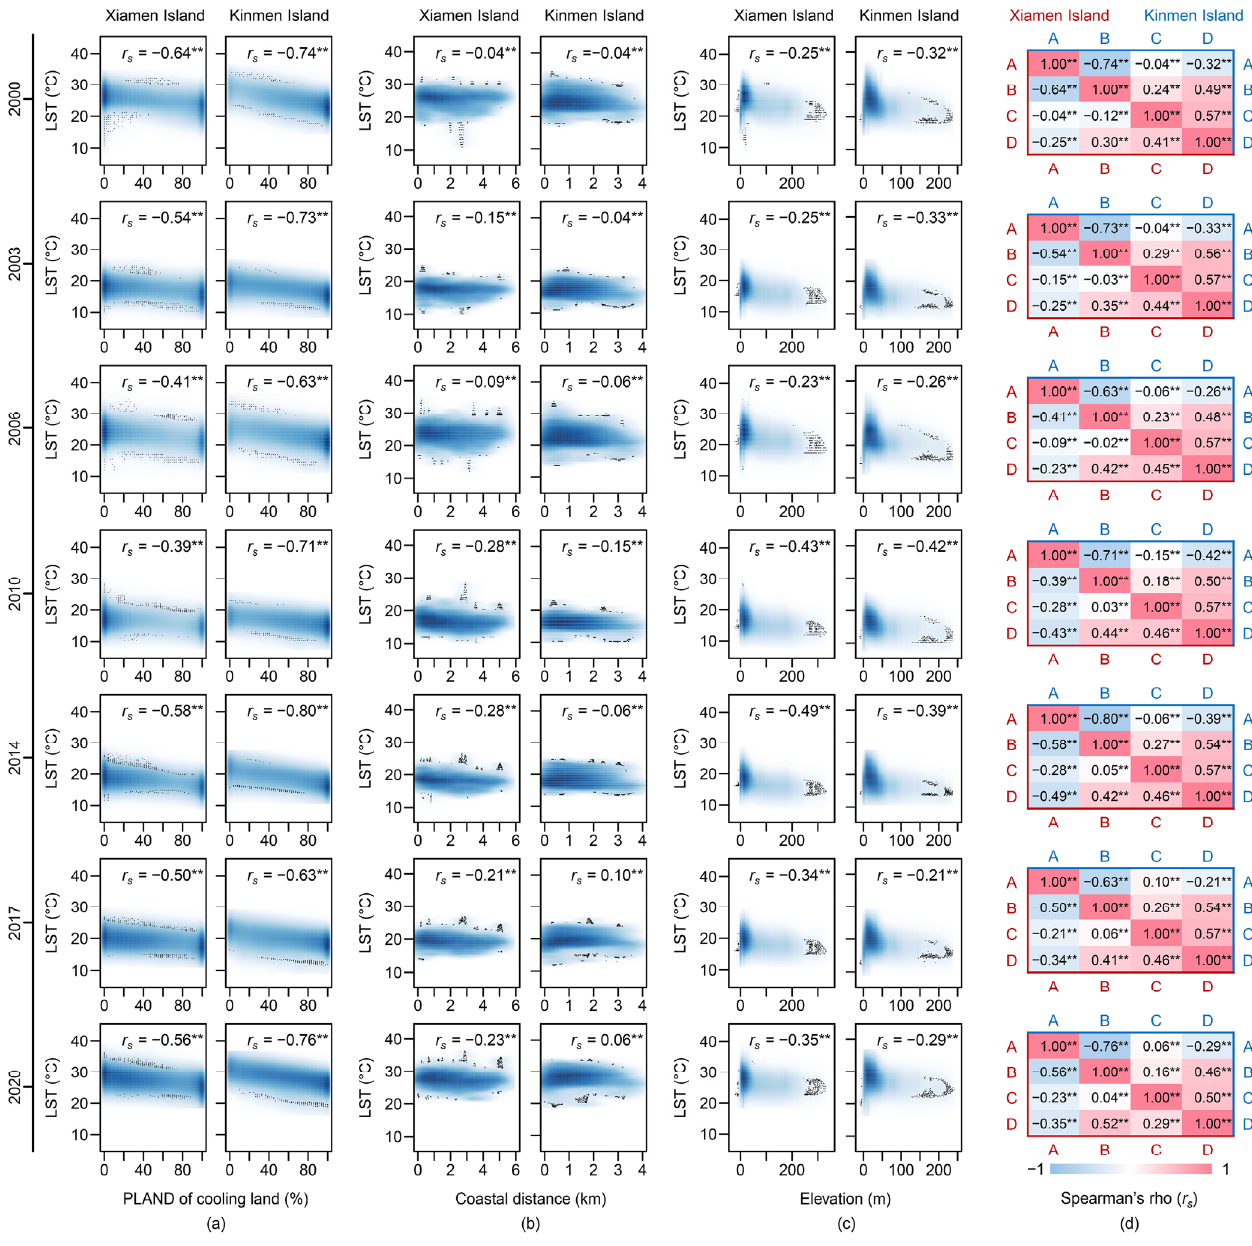
Figure 5. Correlation between LST and its impact factors in the two islands from 2000 to 2020. ( a ) The effect of PLAND of cooling land on LST (the opposite trend for PLAND of warming land); ( b ) The effect of coastal distance on LST; ( c ) The effect of elevation on LST; ( d ) Thermal map of Spearman’s rho among variables (A: LST; B: PLAND of cooling land; C: coastal distance; D: elevation). ** at the 1% significance level.